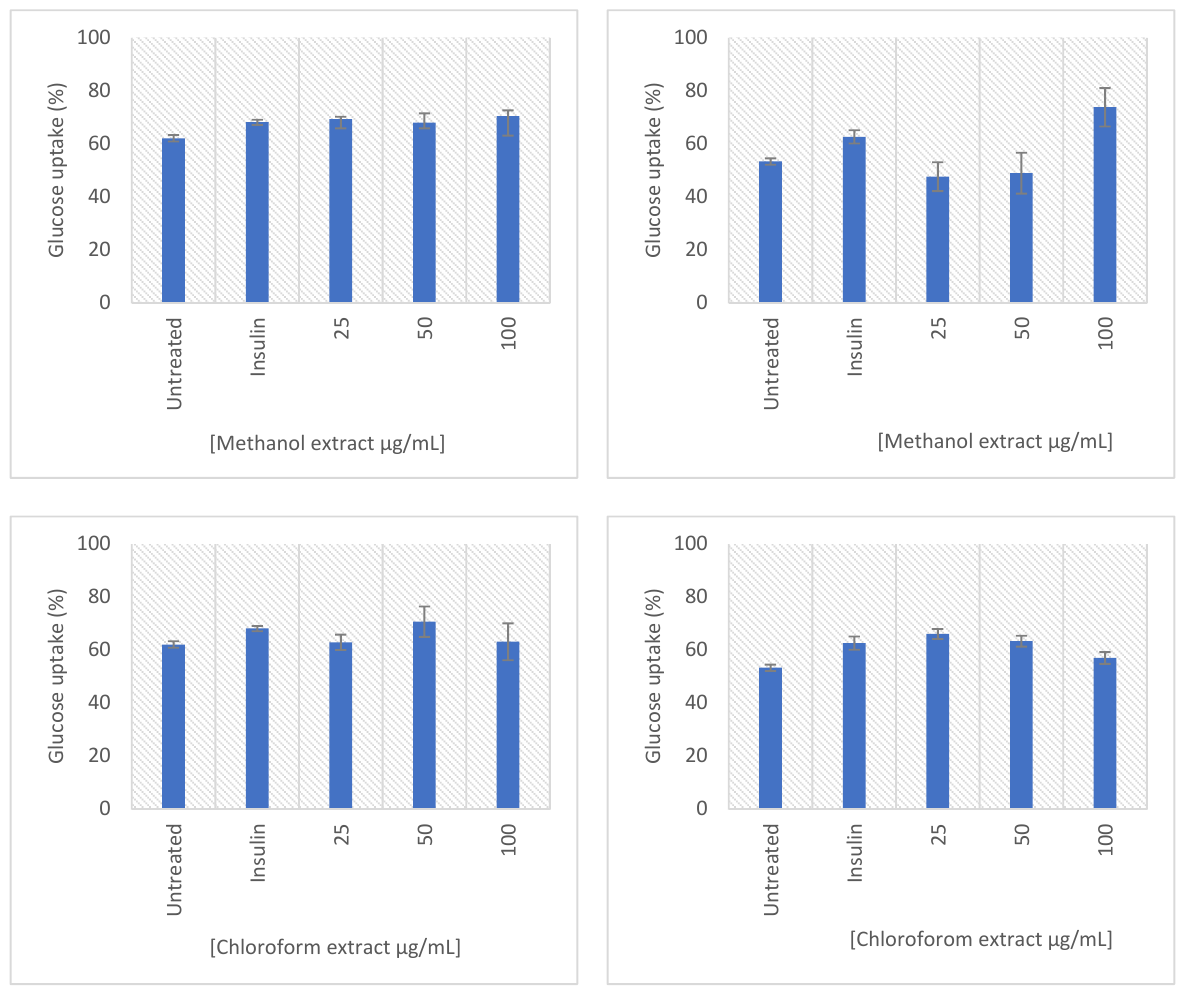
Figure 7. Glucose uptake (%) after 4 h in the L6 myoblasts ( left ) and C3A hepatocytes ( right ), following a 24-h treatment period. Results were normalized to the cell viability as determined using the MTT assay. Error bars indicate the standard deviation of the mean of four replicates from a single experiment.